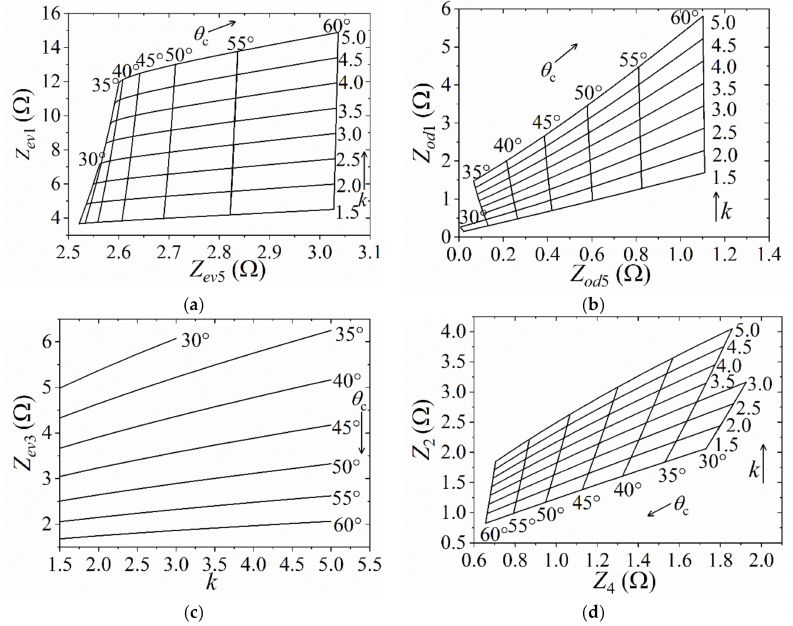
Figure 7. Relationships among characteristic impedance, k and θ c of case 11 under the condition of RL = 20 dB. ( a ) Relationships about Z ev 1 and Z ev 5 . ( b ) Relationships about Z od 1 and Z od 5 . ( c ) Rela- tionships about Z ev 3 and k . ( d ) Relationships about Z 2 and Z 4